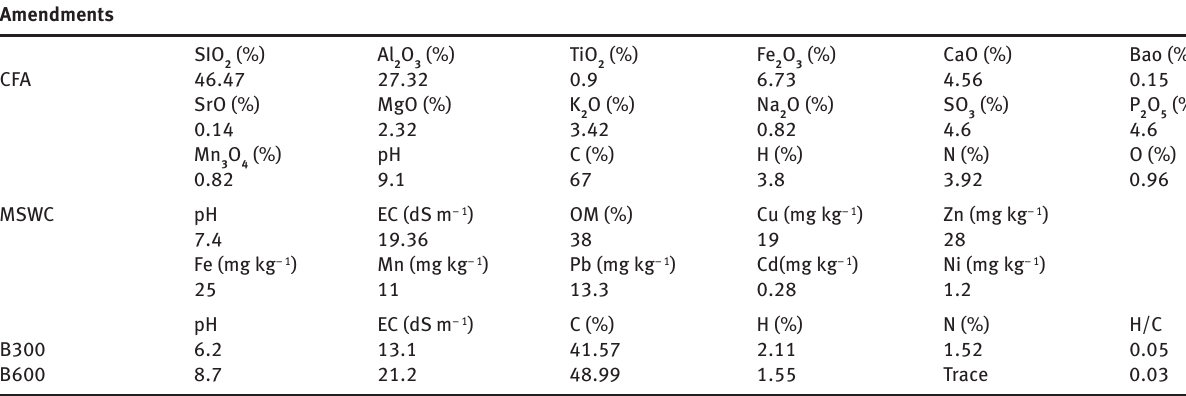
Table 2: Selected chemical properties of amendments used in this study. Amendments